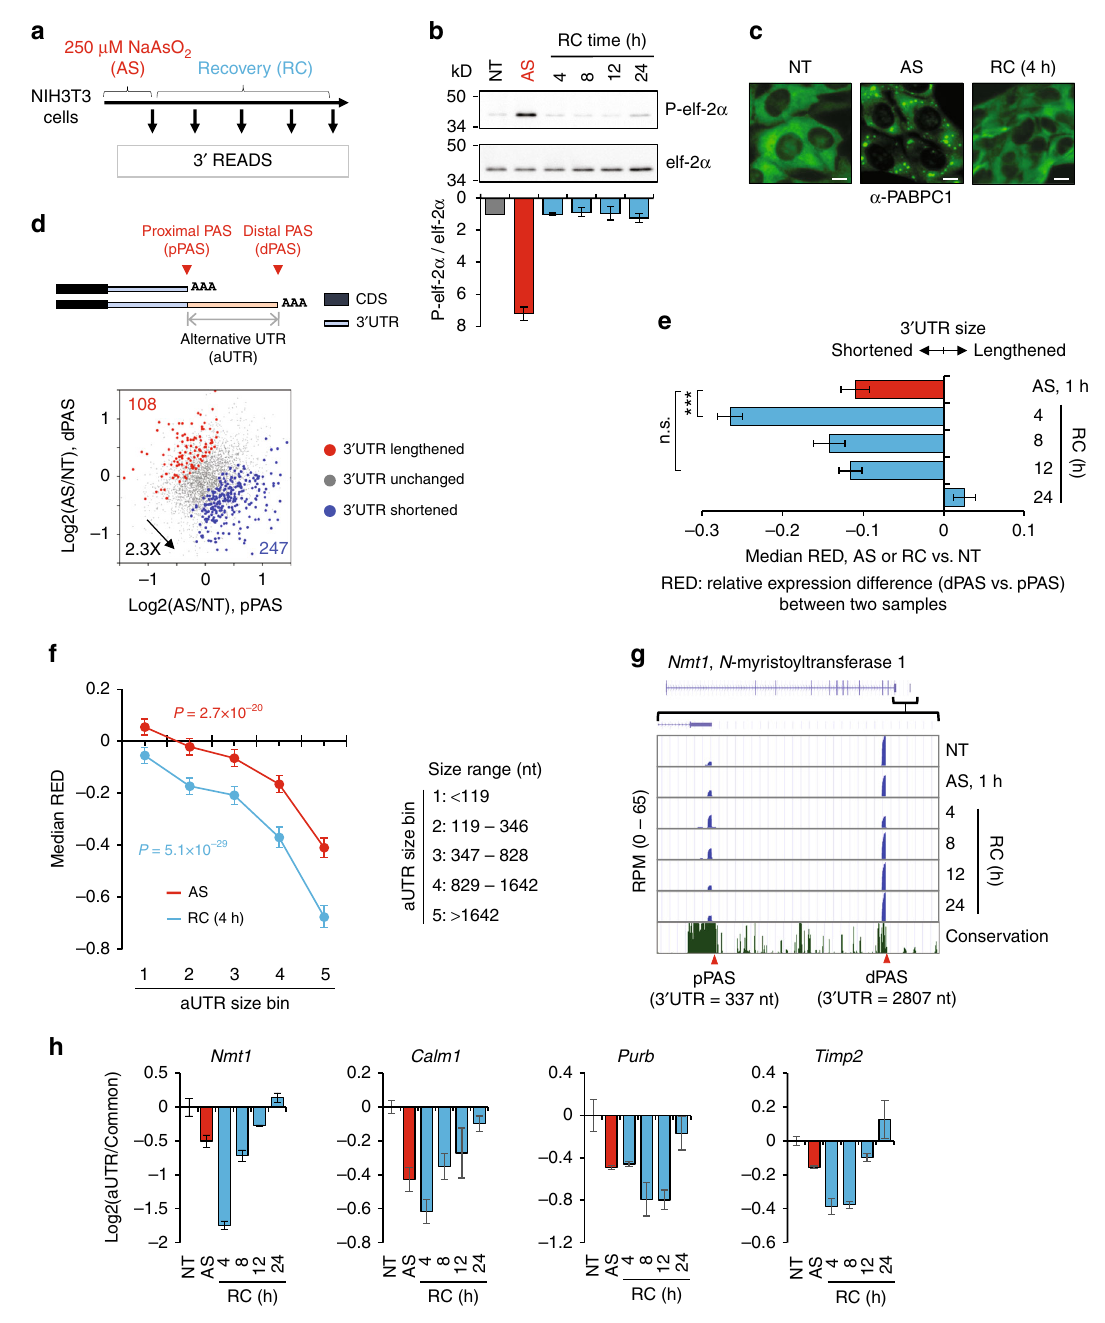
Fig. 1 Arsenic stress elicits global 3 ′ UTR shortening. a Schematic of experimental design. AS, 1 h treatment with 250 µ M sodium arsenite; RC, recovery after AS. b Top, western blot analysis of phosphorylated (upper) and total (lower) eIF-2 α protein. NT non-treated. Bottom, normalized ratio of amount of phosphorylated eIF-2 α to total eIF-2 α . Error bars are standard deviation based on two replicates. c Immunocytochemistry analysis of stress granules (SGs) using anti-PABPC1. Scale bar: 10 µ m. d Top, schematic of two APA isoforms using proximal PAS (pPAS) or distal PAS (dPAS) in the 3 ′ UTR. The region between the two PASs is named alternative 3 ′ UTR (aUTR). Bottom, scatter plot showing expression change of pPAS isoform ( x -axis) and that of dPAS isoform ( y -axis) in total RNA after 1 h of AS. Genes with signi fi cantly shortened or lengthened 3 ′ UTRs ( P < 0.05, Fisher ’ s exact test) based on two biological replicates are highlighted in blue and red, respectively. e Median relative expression difference (RED) values of treatment samples compared to the NT sample, which re fl ect the degree of global 3 ′ UTR length changes. Signi fi cance of difference (Wilcoxon test) is indicated, with three asterisks indicating P < 0.001, and n.s. P > 0.05. Error bars are standard deviations based on random sampling of data for 20 times. f Relationship between RED and aUTR size. Genes were divided into fi ve bins based on aUTR size. Median RED for each gene bin is shown for AS (red line) or RC (blue line) vs. NT cells. Error bars are standard error of mean. P -values (Wilcoxon test) are based on difference between gene bins 1 and 5. g 3 ′ READS data of an example gene Nmt1 , visualized in UCSC genome browser. Expression levels of isoforms are indicated by reads per million (RPM) PAS reads. Note the RefSeq track at the top does not cover the dPAS due to poor annotation. h RT-qPCR analysis of the relative amounts of APA isoforms ( x -axis). Two primer sets were used for each gene, targeting a common region to both isoforms and the aUTR, respectively. The log2(aUTR/common) value ( y -axis) indicates relative abundance of long vs. short 3 ′ UTR isoforms. Error bars are standard deviation based on two